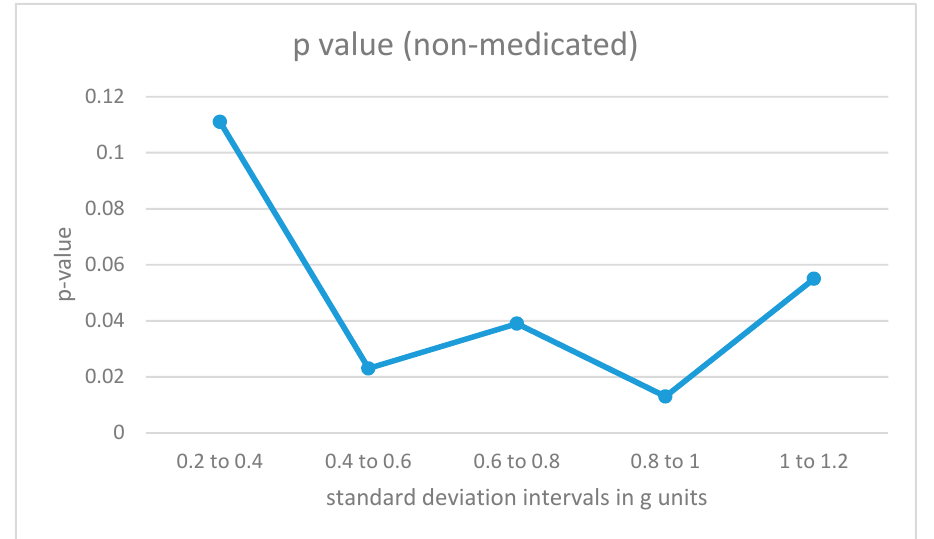
Figure 6. p-Values for acceleration intervals with different movement intensities for non-medicated participants with ADHD.